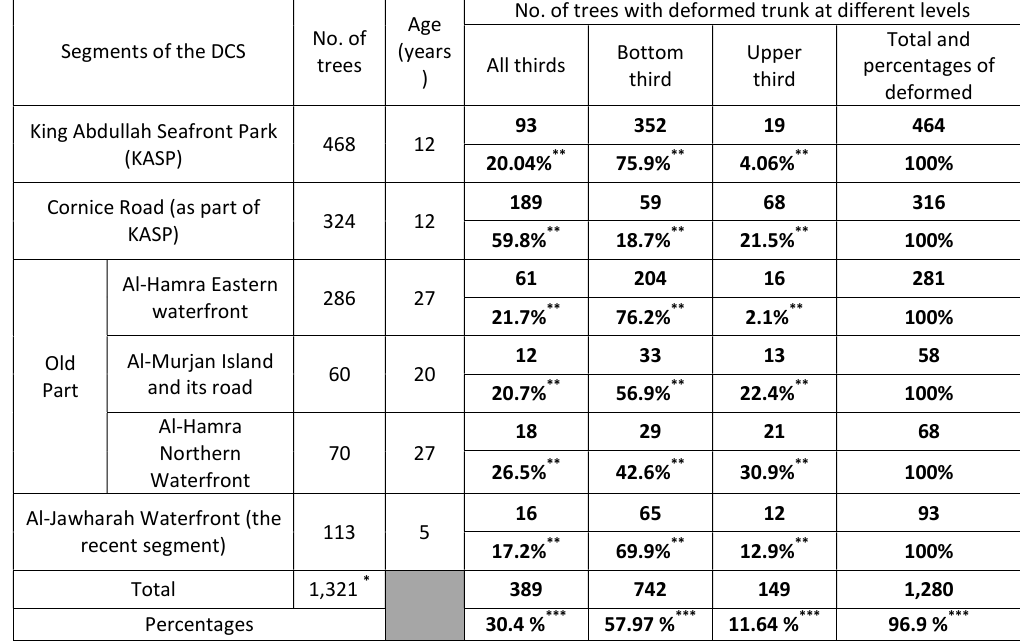
Table 1: Distribution of the date palm trees in different zones of the Dammam City Seafront (DCS), includes numbers and percentages of trees with deformed trunk in each segment of the D